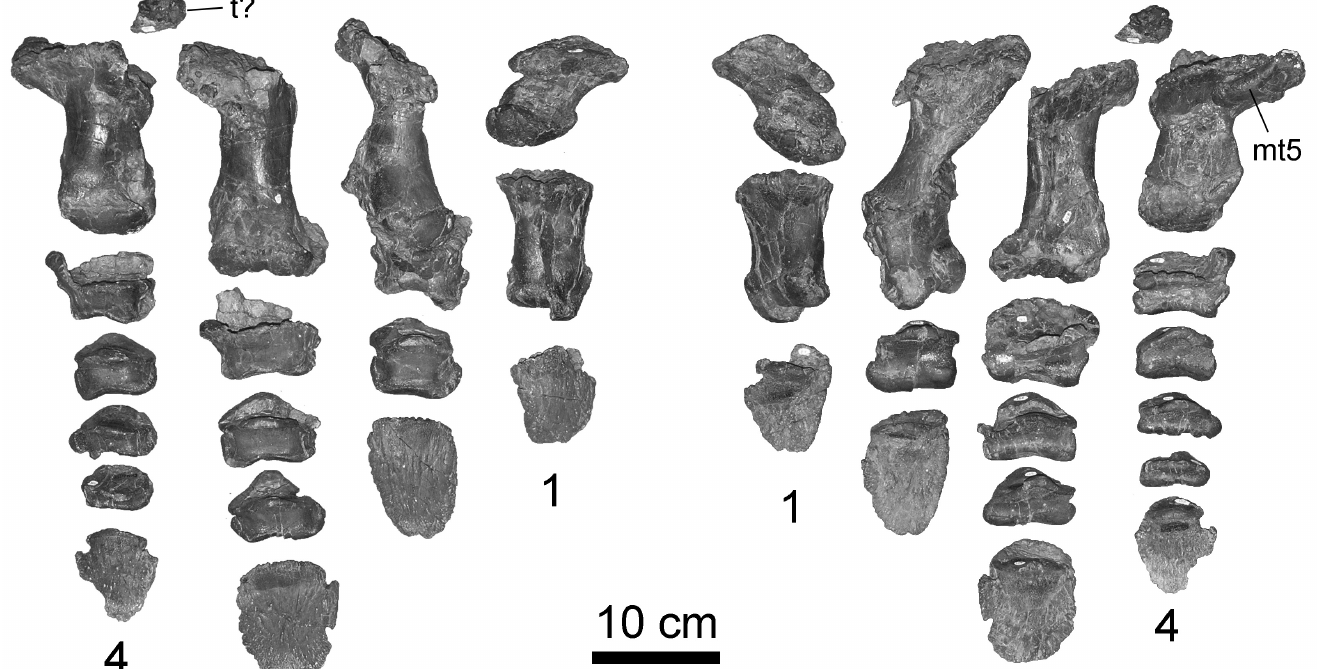
Figure 22. Right pes in dorsal (left) and ventral (right) views. 1, first digit. 4, fourth digit. Vagaceratops irvinensis , CMN